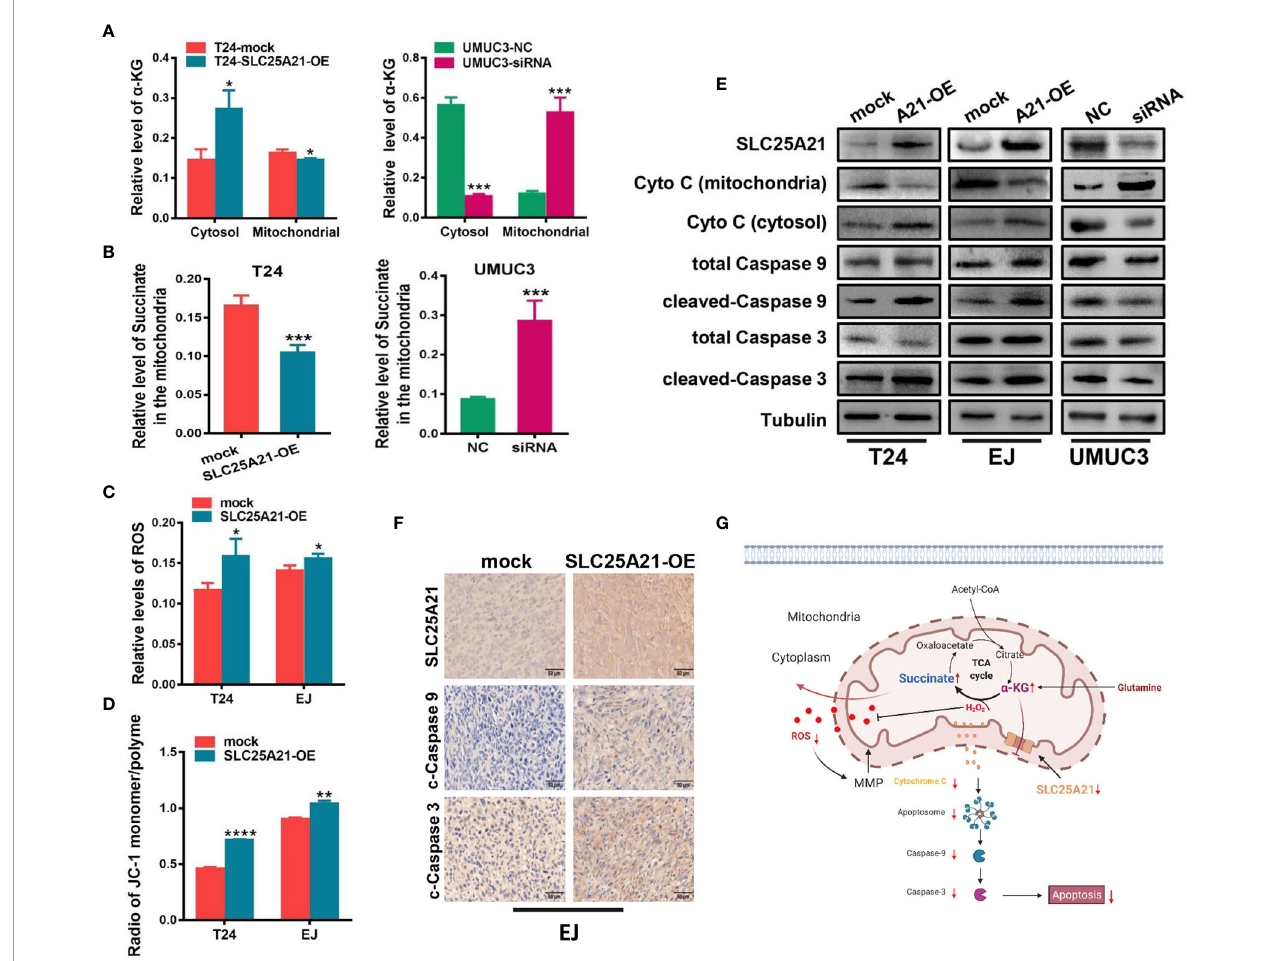
FIGURE 5 | SLC25A21 overexpression induces cell apoptosis by the a -KG-mediated ROS pathway in BCa. (A) SLC25A21 promoted the ef fl ux of a -KG from the mitochondria to the cytosol. (B) The levels of a -KG in the mitochondria affected succinate production. (C) The upregulation of SLC25A21 promoted ROS accumulation in BCa cells. (D) The upregulation of SLC25A21 decreased Dy m in both BCa cell lines. (E) Western blot assays showed that SLC25A21 induced cyto C transfer from the mitochondria to the cytosol and increased the activation of caspase-9 and caspase-3 in BCa cells. (F) Immunohistochemistry showed that SLC25A21 increased the activation of caspase-9 and caspase-3 in BCa xenograft tissues. (G) Schematic diagram showing the mechanism of action of SLC25A21 on cell apoptosis in BCa. The results were reproducible in three independent experiments. * P < 0.05, ** P < 0.01, *** P < 0.001 and **** P <